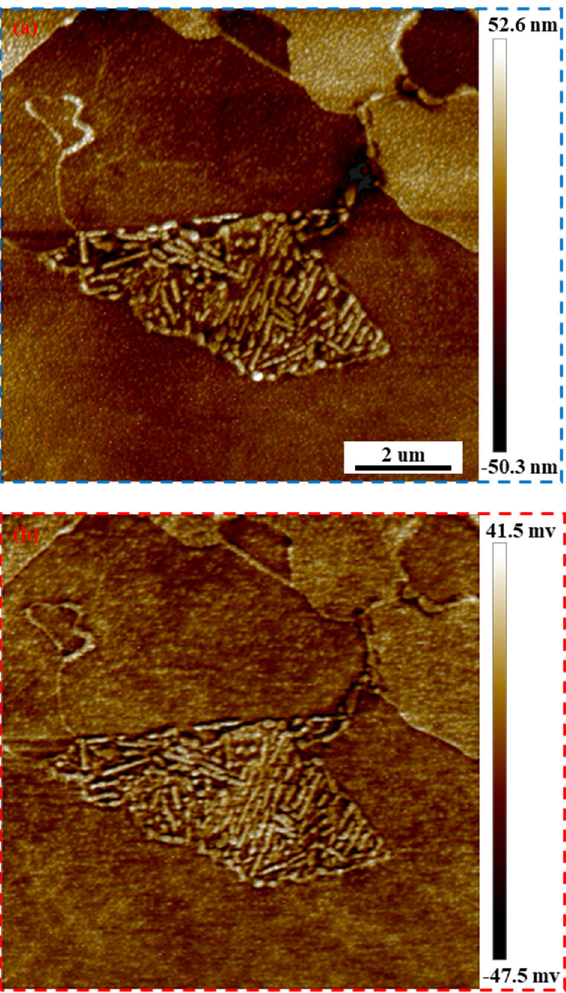
Fig. 5 SKPFM characteristics of grain boundaries and pearlite regions. a Topography diagram and b Volta potential